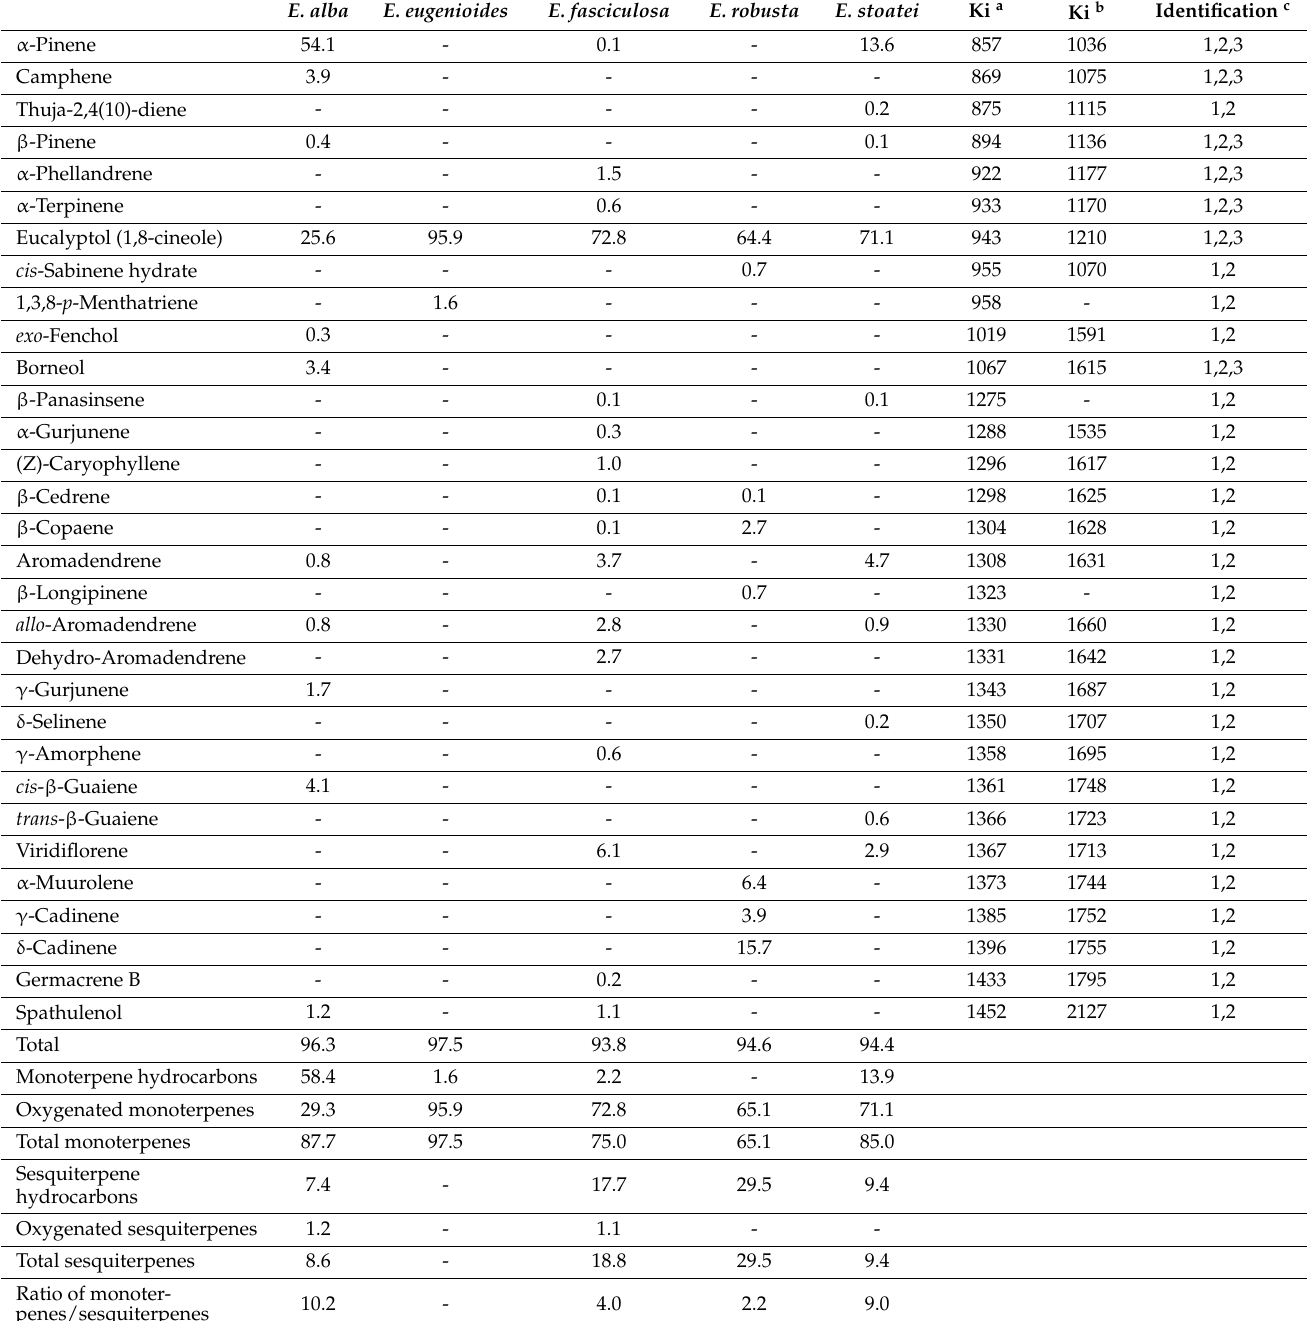
Table 2. Chemical composition of the